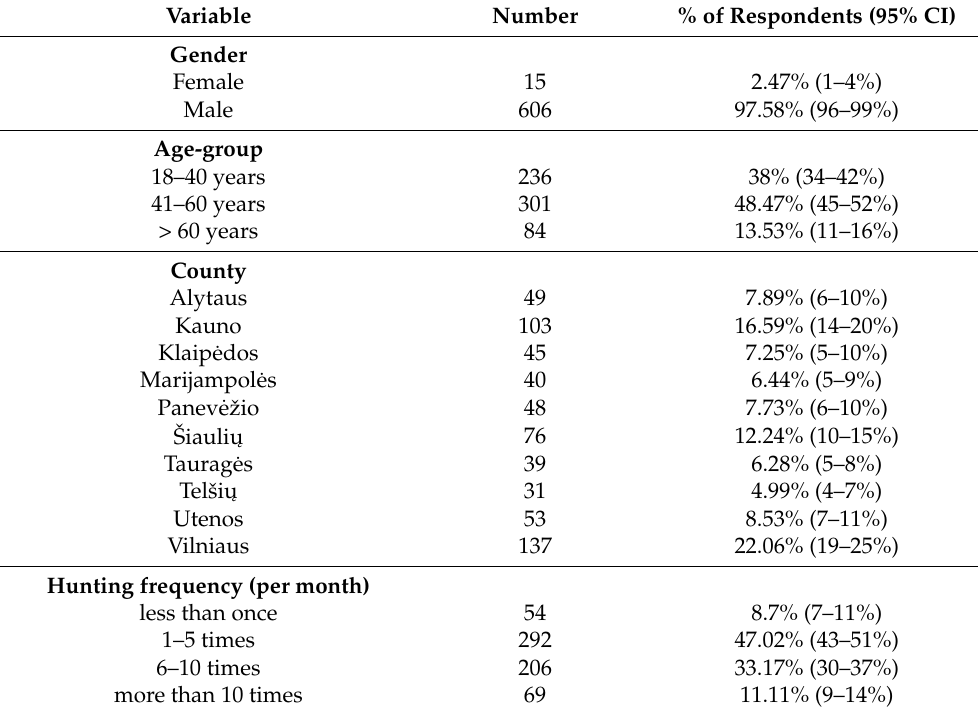
Table A1. Demographic data of the Lithuanian hunters responding to the questionnaire survey.